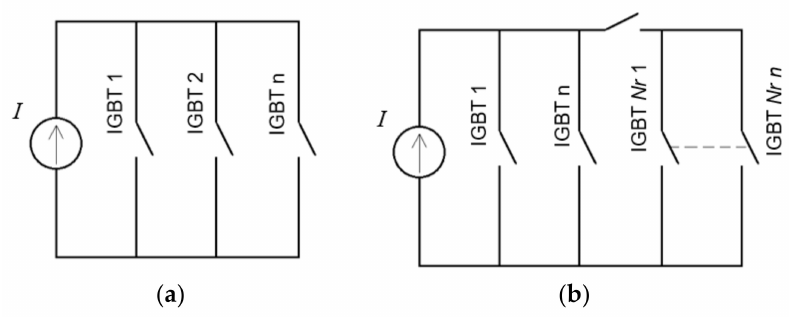
Figure 3. ( a ) Nsim; ( b ) NNr algorithms’ basic